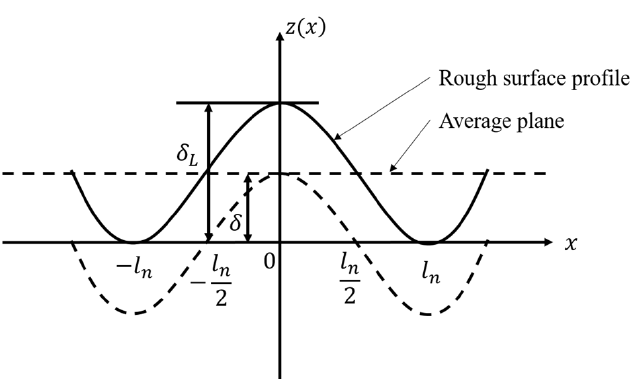
Figure 6. Longitudinal section of the leakage microchannel.